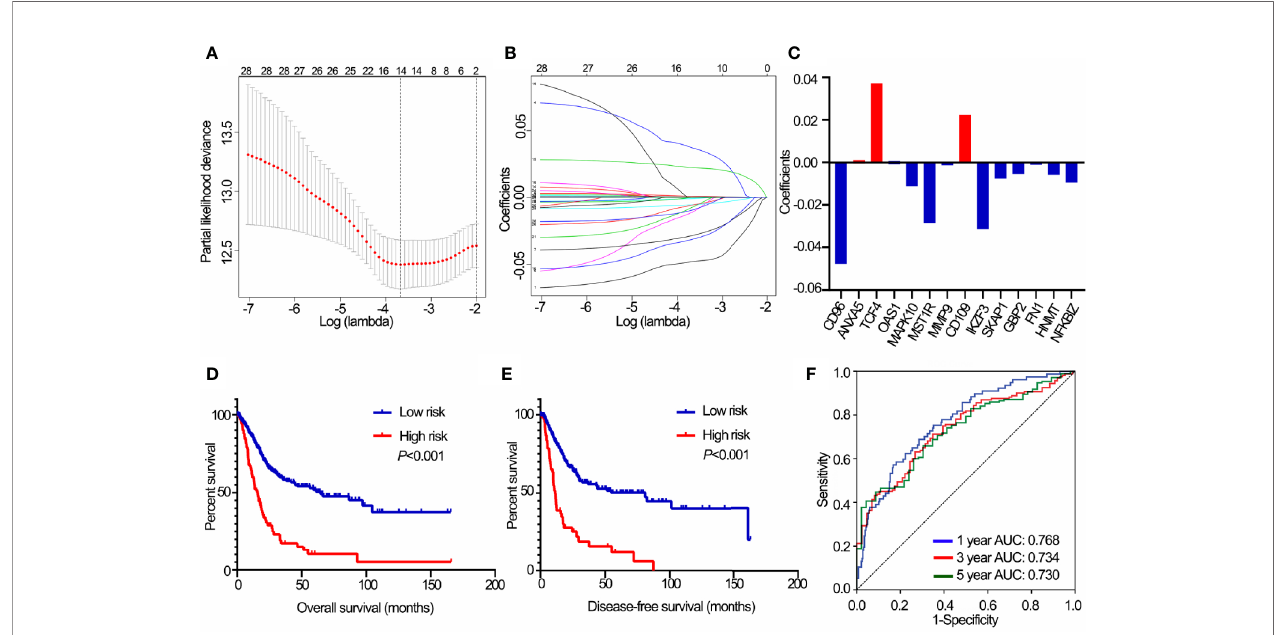
FIGURE 3 | Construction of the IPS using LASSO Cox analysis in TCGA data set. (A) Plots of the cross-validation error rates. (B) Distribution of LASSO coef fi cients of OS-associated immune genes. (C) Coef fi cient values of each of the 14 OS-associated immune genes. (D) Kaplan-Meier curves of OS for BLCA patients based on the IPS. (E) Kaplan-Meier curves of DFS for BLCA patients based on the IPS. (F) Receiver operating characteristic curve showed the predictive ef fi ciency of the IPS on 1-, 3-, and 5-year survival rates. IPS, immune prognostic signature; LASSO, least absolute shrinkage and selection operator; TCGA, The Cancer Genome Atlas; BLCA, bladder cancer; OS, overall survival; DFS, disease-free survival. AUC, area under